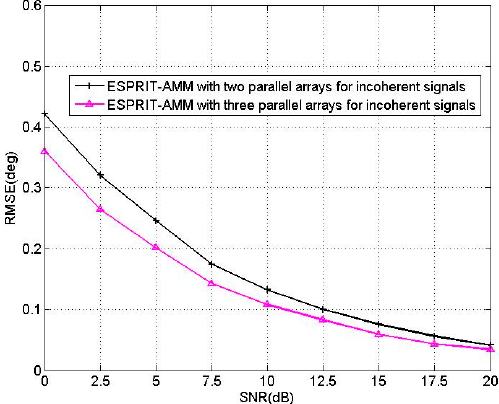
Figure 11. RMSE of the BCM/ESPRIT-AMM algorithms versus SNR.